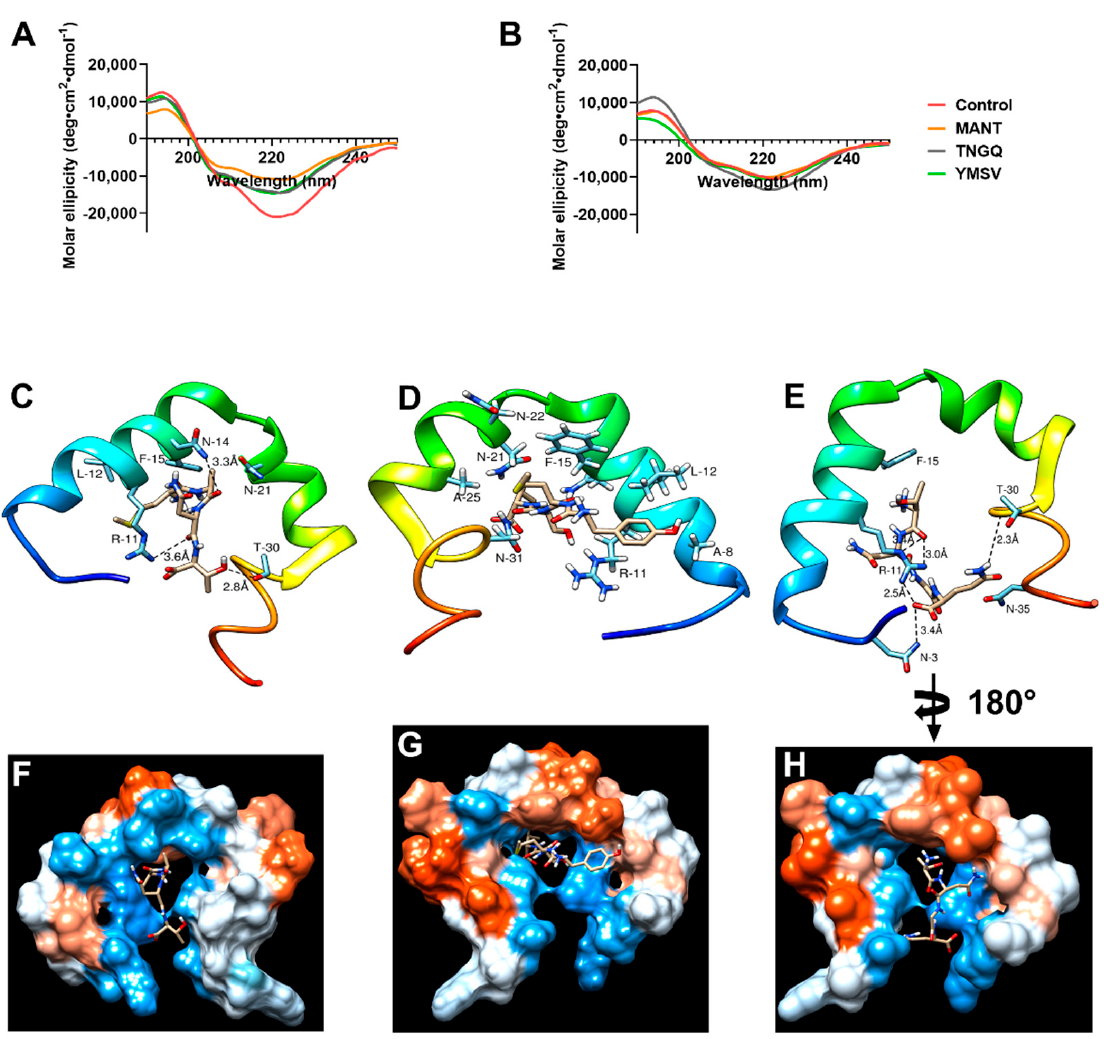
Figure 2. Circular dichroism spectra of IAPP in the absence (control) and presence of MANT, TNGQ, and YMSV at ( A ) the initial time point (0 h) and ( B ) late stationary phase (48 h) of fibrillation. Docking scheme showing intermolecular interactions between ( C ) MANT, ( D ) YSMV, or ( E ) TNGQ and monomeric IAPP at the various hydrophobic and hydrophilic regions ( F – H ), respectively. Kyte–Doolittle scale was used to evaluate hydrophobicity with colors ranging from dodger blue (the most hydrophilic) to white 0.0 to orange-red (the most hydrophobic).